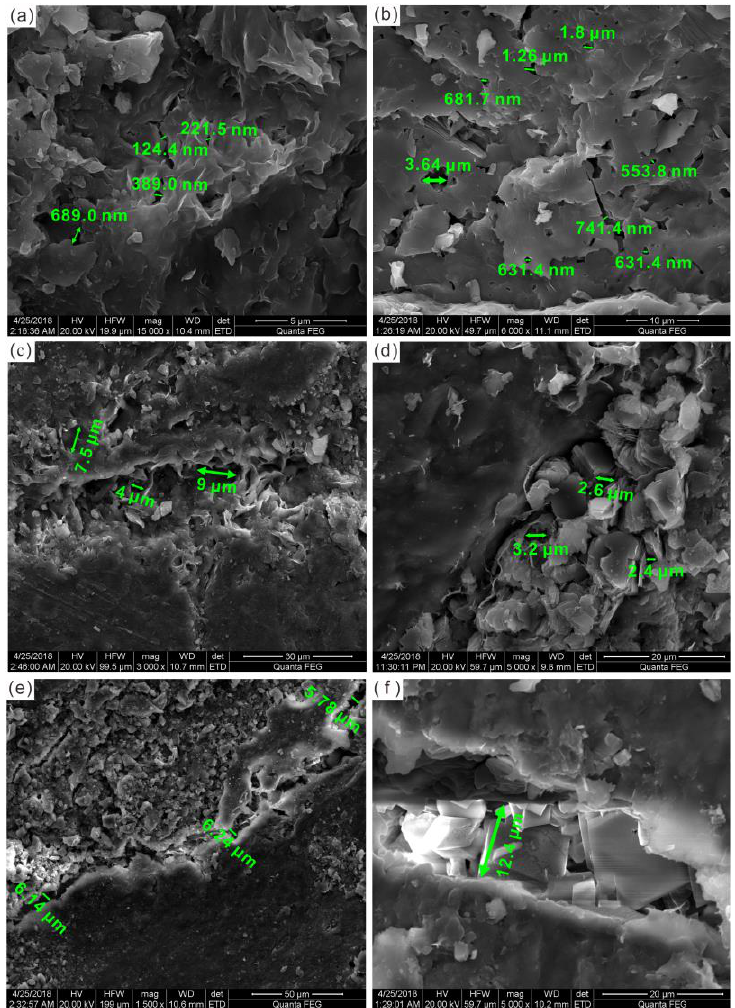
Figure 6. Reservoir characteristics of distinct weathering crust belts. ( a ) Dissolved matrix pores, Dp7, 2170.6 m; ( b ) Intergranular and intragranular matrix pores, Jb1, 4645.9 m; ( c ) Dissolution pores, N4, 998.2 m; ( d ) Residual pores, Nb1, 3742.37 m; ( e ) Dissolution fractures, N4, 998.2 m; ( f ) Tectonic fractures, South Datonggou, DT-1.